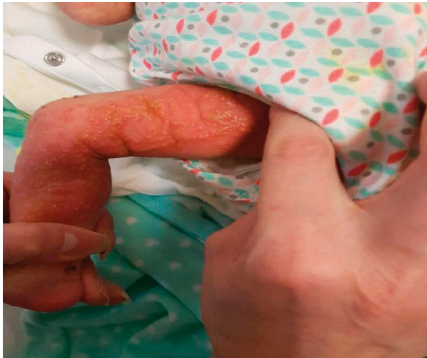
Figure 1: The appearance of skin lesions on the lower extremity of the patient. Note the linear pattern of the skin lesions.